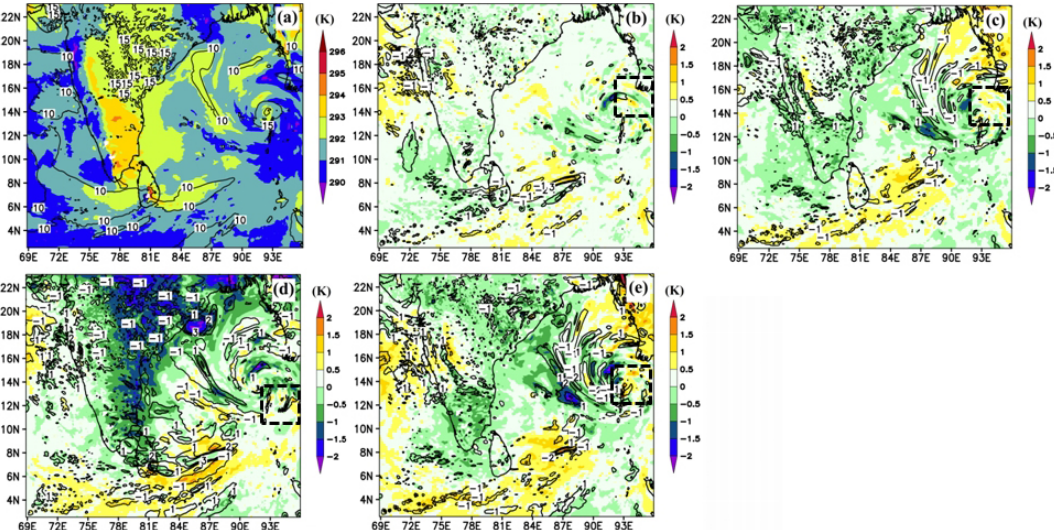
Figure 5. Spatial distribution of (a) initial temperature (shaded) and specific humidity (contours with interval of 1gkg − 1 ) at 850hPa in CTL and analysis difference (VAR − CTL) in (b) VARAMV, (c) VARPREP, (d) VARRAD and (e) VARPREP + RAD for Phailin at 12:00UTC 9 October 2013.